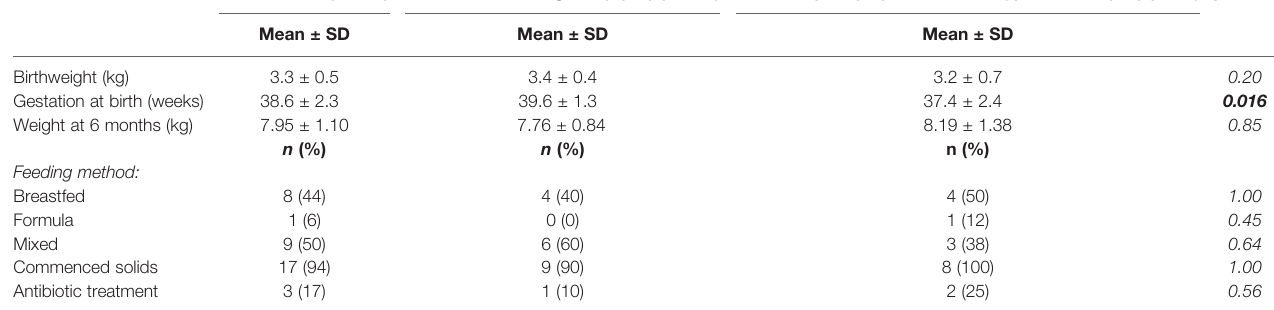
TABLE 2 | Infant characteristics.